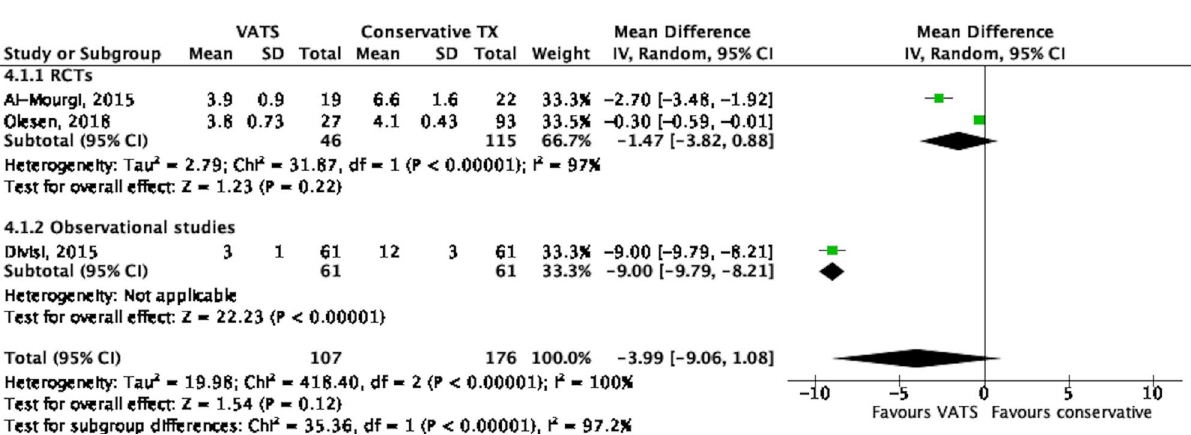
Figure 4. Forest plot of the comparison of duration of hospital stay between VATS and conservative treatment.